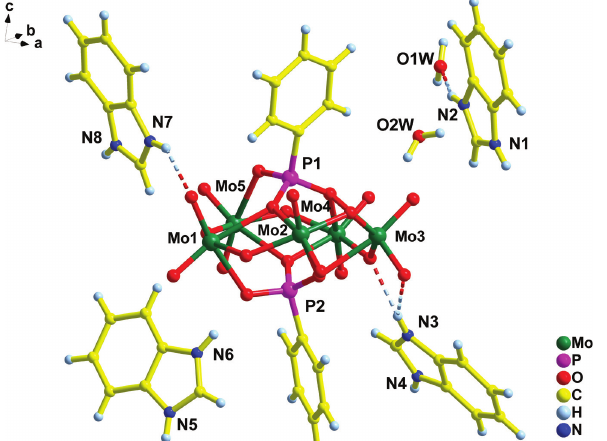
Table 2: Fractional atomic coordinates and isotropic or equivalent isotropic displacement parameters (Å 2